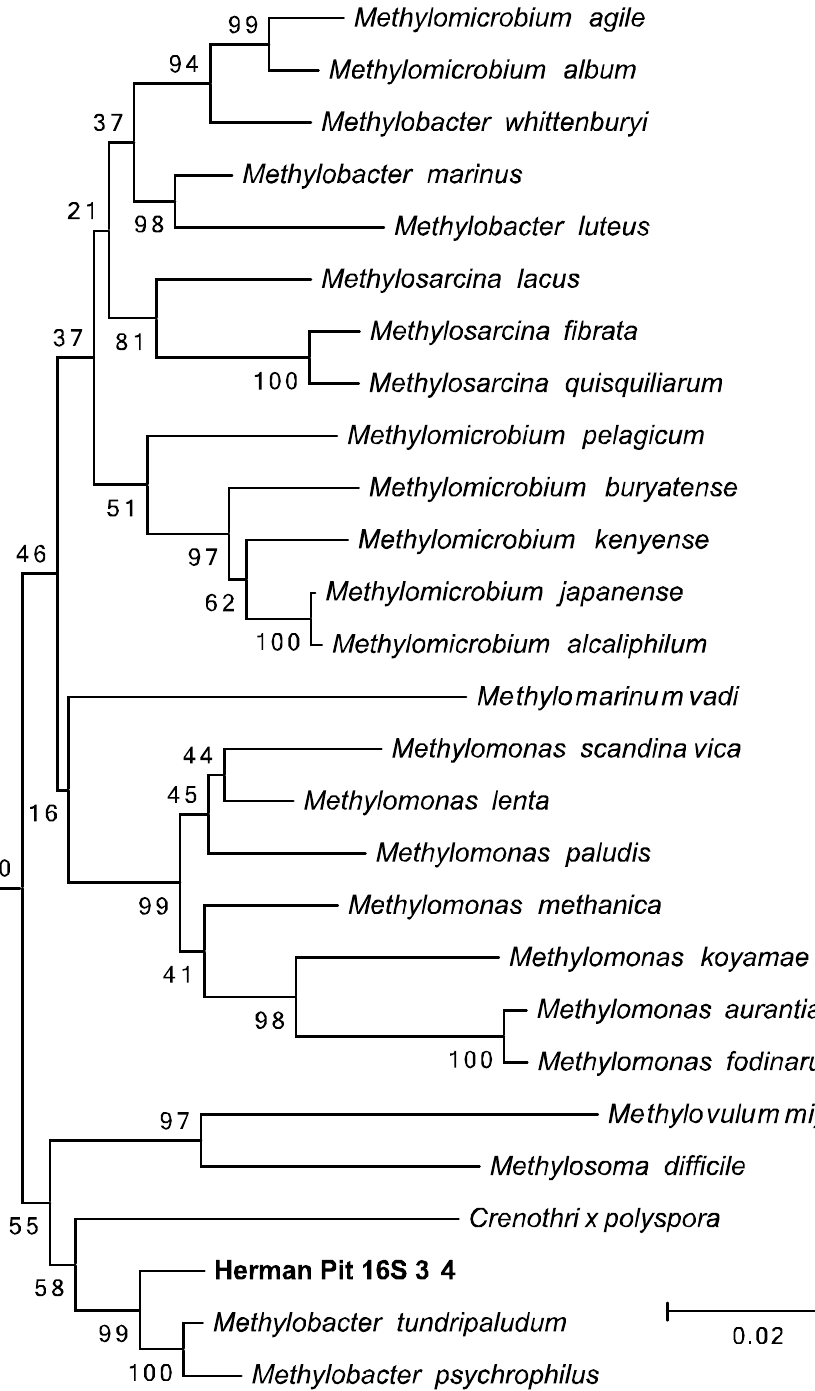
Figure 5. Neighbor-joining tree of one 16S rRNA gene amplified from the Herman Pit enrichment sample demonstrating its close relationship to the Gammaproteobacterial class of aerobic